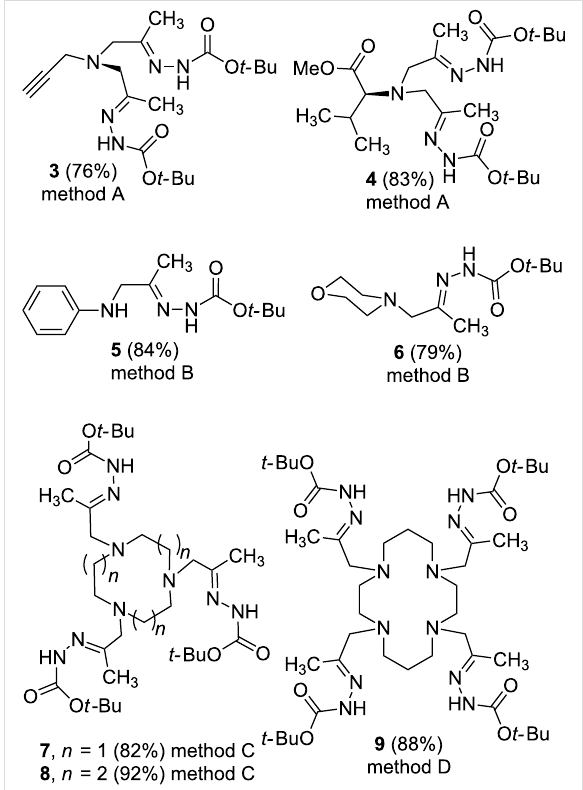
Figure 2: Structures of polyhydrazones 3 - 9 . Methods: A: 1 equiv of amine, 2 equiv of 1a , 2 equiv of K 2 CO 3 ; B; 1 equiv of amine, 1 equiv of 1a , 1 equiv of K 2 CO 3 ; C; 1 equiv of amine, 3.1 equiv of 1a , 3 equiv of K 2 CO 3 ; D. 1 equiv of amine, 4.2 equiv of 1a , 4 equiv of K 2 CO 3 . Yield based on the amine used.